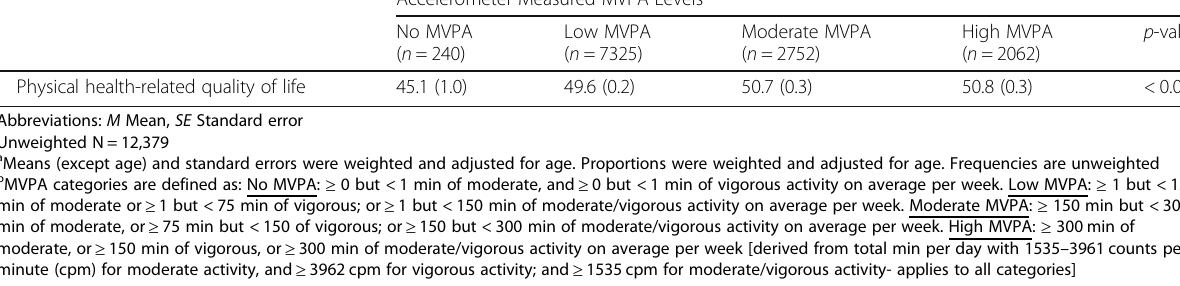
Multivariable linear regression models Mental health-related quality of life